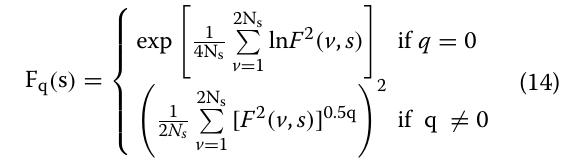
40% a P-P fault, b P-P-G fault, c N-P-G fault, c series arc, d shunt =